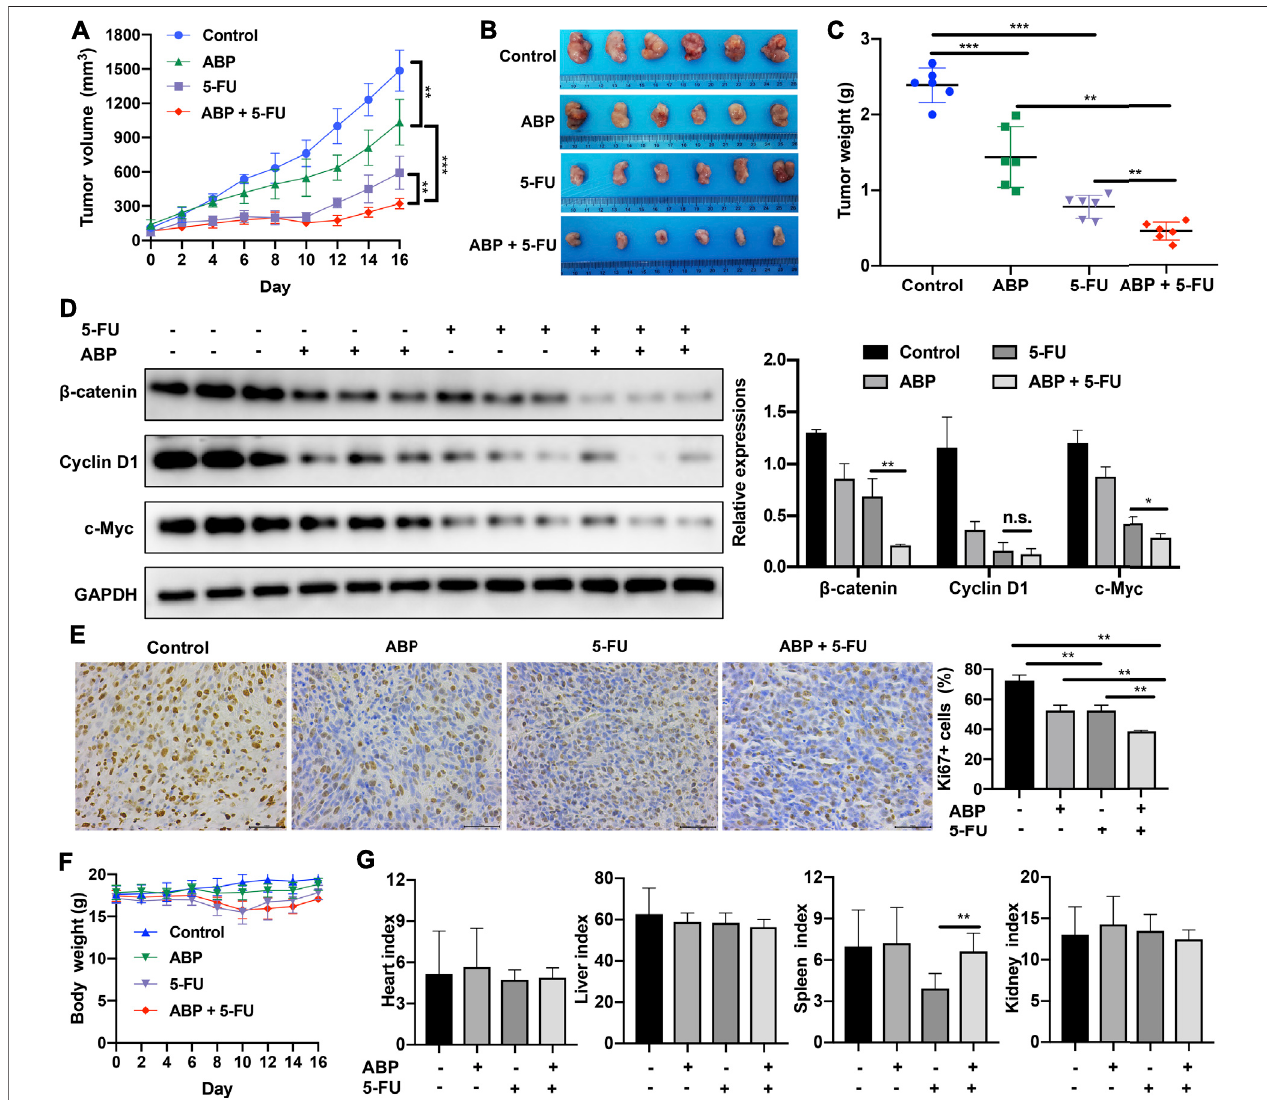
FIGURE5| ABPexhibitssynergisticanti-tumoreffectswhenadministeredincombinationwith5-FUinmicebearingCT26tumors. (A) Tumorvolumesmeasuredat the indicated time points. Data are shown as mean ± SD (n (cid:2) 6 mice at each time point). (B) Image of tumors resected from sacri fi ced mice at the end of the treatment period. (C) Tumor weights measured after surgicaltumor removal, represented as mean ± SD. (D) Western blot examining the levels of β -catenin, Cyclin D1, and c-Myc in subcutaneous tumors, with GAPDH used as the internal control. (E) Images of Ki67 immunohistochemical staining ( × 400) in tumor cells and quanti fi cation of Ki67-positivetumorcells.Scalebar (cid:2) 50 μ m. (F) Bodyweightsmeasuredevery2 days. (G) Organindexescalculatedastheratiooforganweight(mg)tobodyweight(g) at the end of the treatment period. Data are means ± SD ( n (cid:2) 6). * p < 0.05, ** p < 0.01, *** p < 0.001.